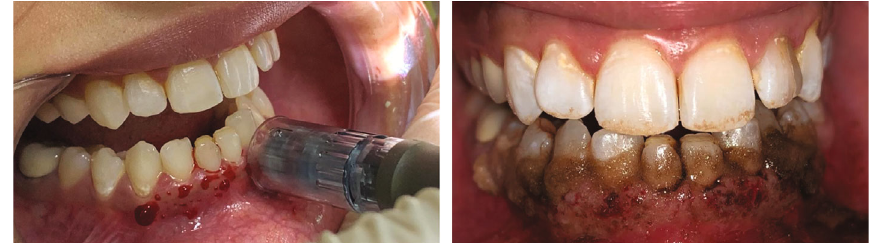
Figure 2: Microneedling technique using dermapen and ascorbic acid (vitamin C)